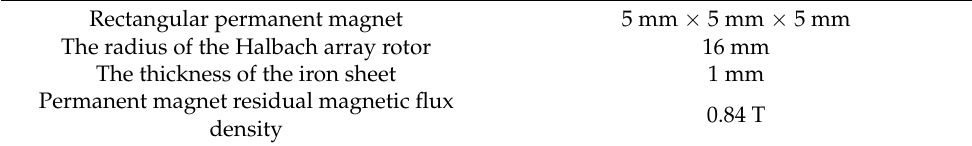
Table 1. Parameters used in the experiment.